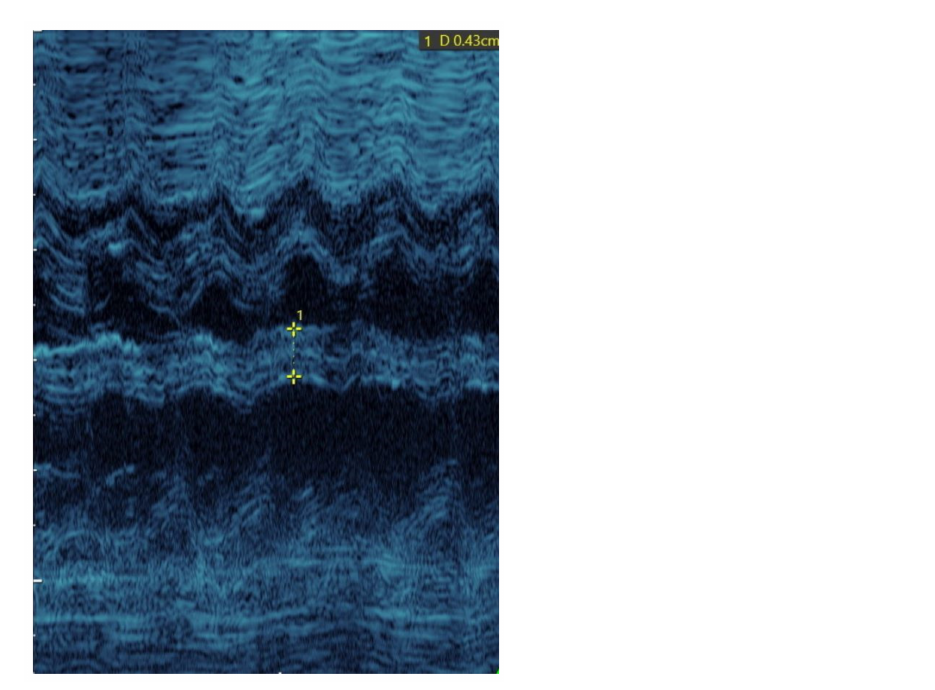
Figure 2. Example of interventricular septal thickness measurement obtained by M-mode echocar- diography in the